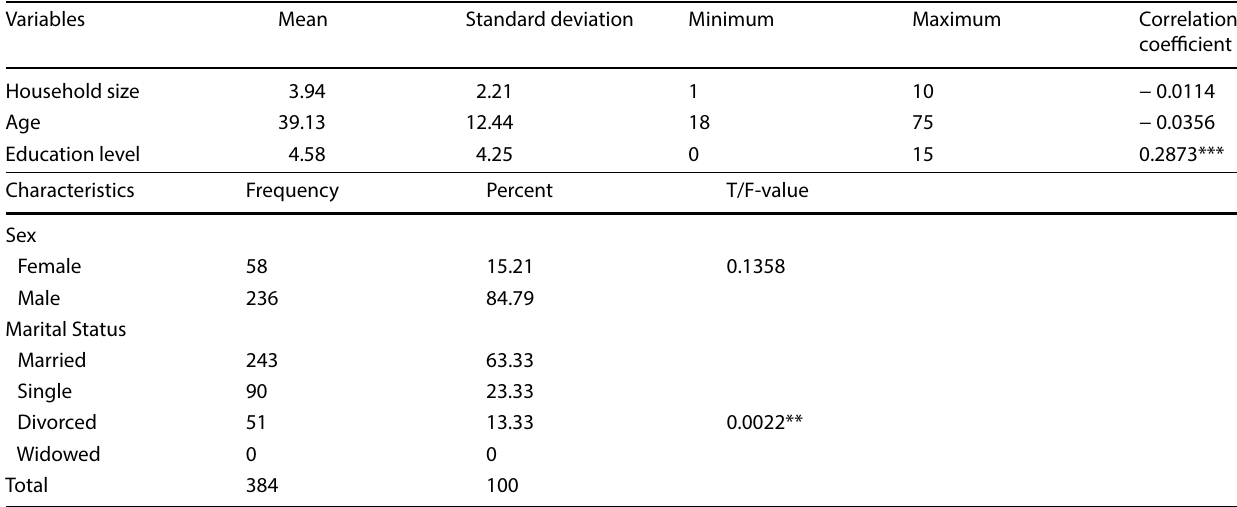
Table 2 Demographic characteristics of the sample